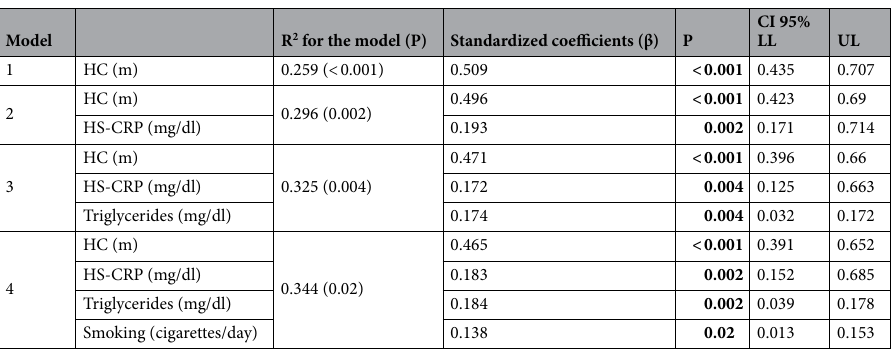
Table 4. Forward linear regression between obesity parameters and socio-demographic and health variables, and the number of stented coronary arteries ( N = 220). The last model explained 34.4% of the variation of frailty score (P = 0.02). Significant values are in bold.